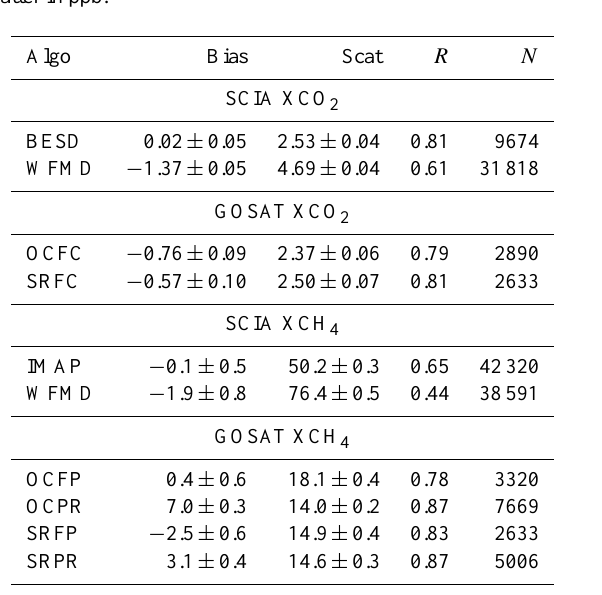
Table 13. Overview table, listing all overall (ALL) results. The listed uncertainties on the bias and scatter correspond to the 0.95 confidence interval. XCO 2 bias and scatter inppm, XCH 4 bias and scatter in ppb.